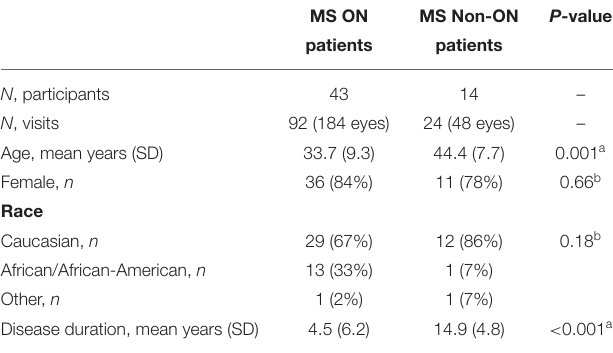
TABLE 1 | OCTA image quality control.